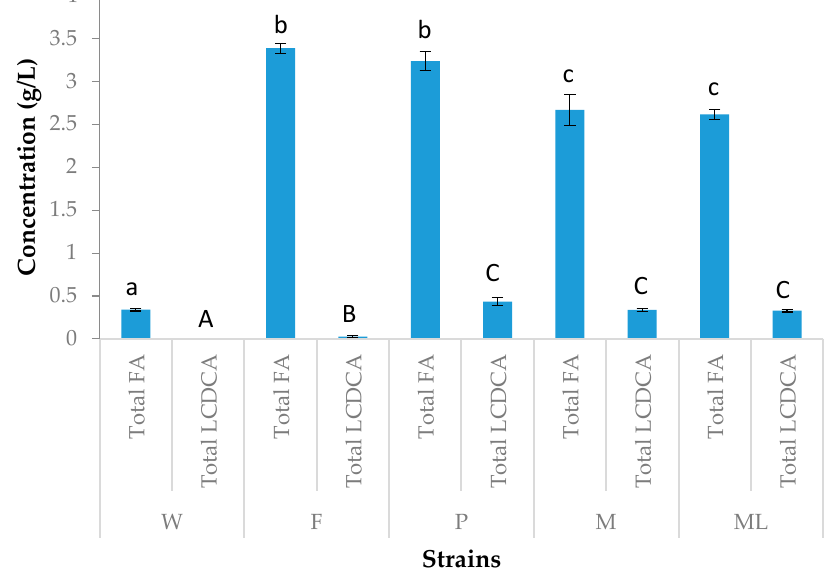
Figure 3. Study of 6-day shake flask cultures for fatty acid and LCDCA production by the H, F, P, M, and ML strains/treatment. Glycerol based media under nitrogen-limiting conditions (C/N = 50). Error bars a represent standard deviation of n = 3. W: H222 wild type strain, F: ∆ POX1-6 ∆ LEU2 ∆ SNF1 ∆ FAA1 ∆ SNF1 :: URA3 , P: F + ∆ LEU2 :: URA3 YlALK5 YlCPR YlFAO1 , M: P + YlALK5 :: URA3 , ML: M + 400 mg/L leucine. Total FA: total fatty acids of 16 and 18 carbons, Total LCDCA: total long chain dicarboxylic acids of 16 and 18 carbons. ABC/abc Columns with dissimilar letters at the top are significantly different ( p < 0.05).